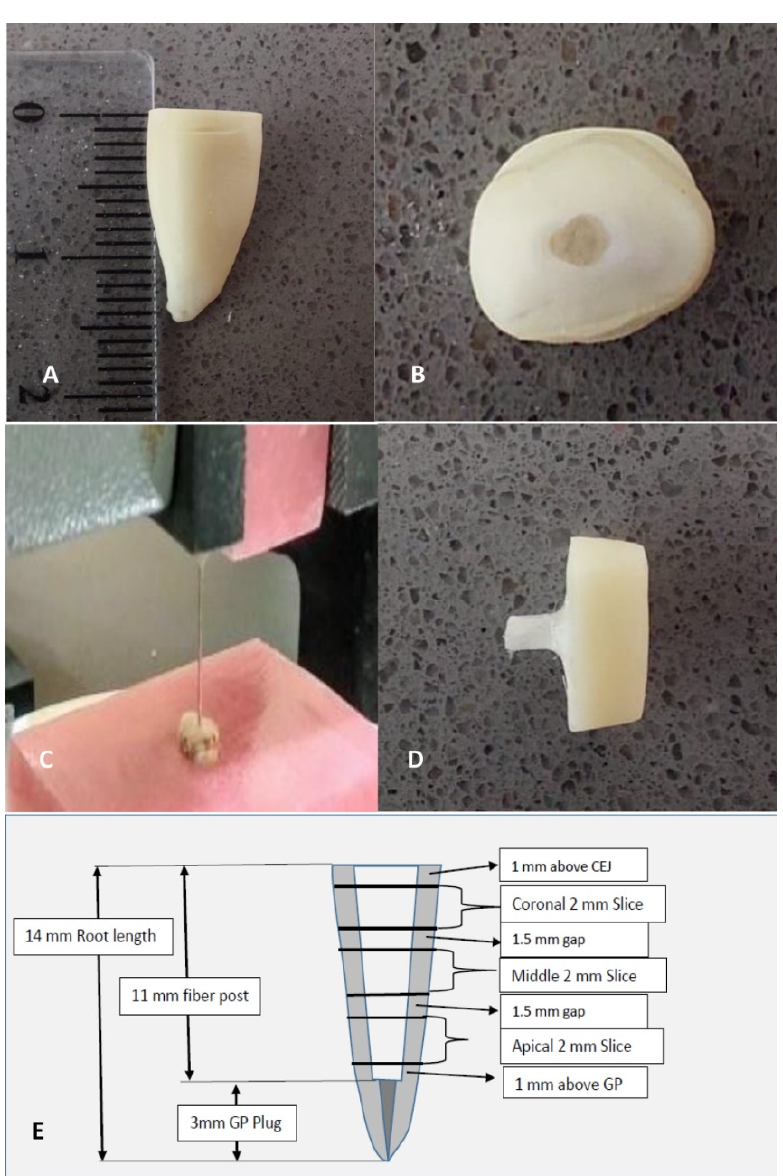
Figure 2. Pictorial illustration of the methodology. ( A ): 14 mm sectioned root; ( B ) Fiber post placed; ( C ) Push-out test performed using Universal Testing Machine; ( D ) Push-out fiber post from the root section; ( E ) Schematic illustration of root sectioning.